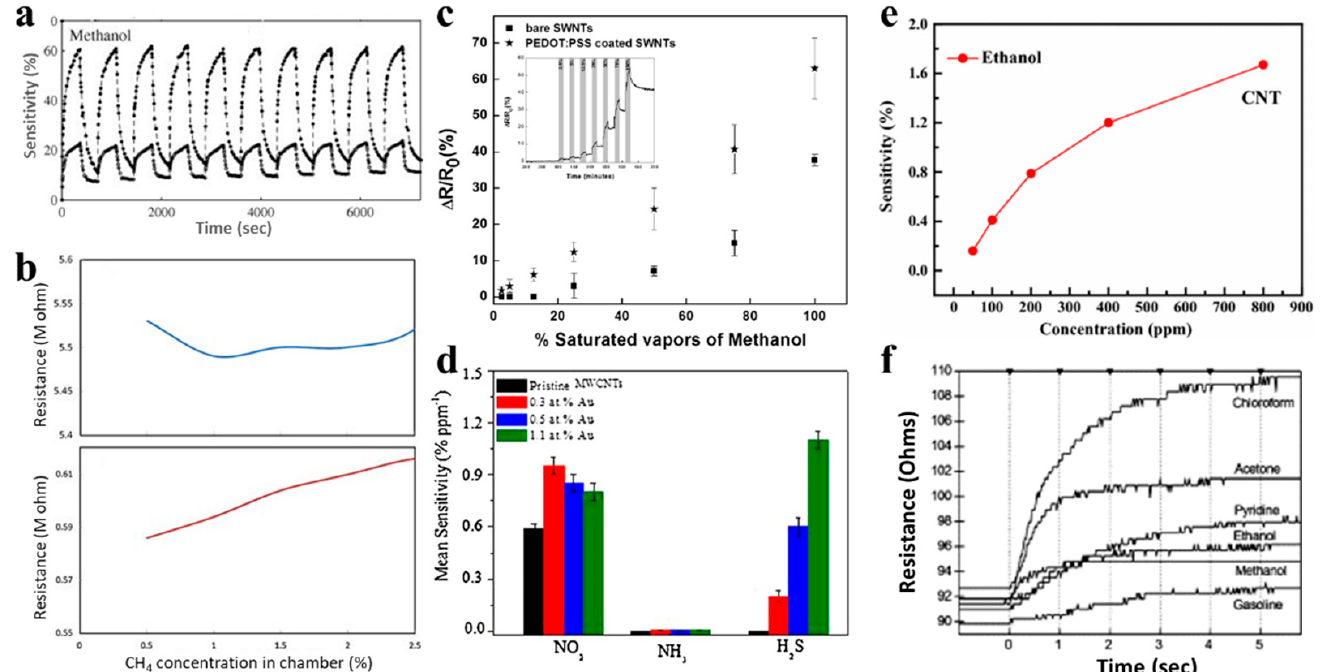
Figure 3. CNTFET-based gas sensor. ( a ) The response of CNTFET to methanol with (open symbols) and without (filled symbols) KMnO 4 treatment [48]. ( b ) The response of polyaniline (PANI) (top) and multi-walled CNT (MWCNT)-PANI (bottom) membranes to methane gas [49]. ( c ) The response of SWCNTs with PEDOT:PSS coating to methanol [42]. ( d ) Selective response of CNTFET sensor